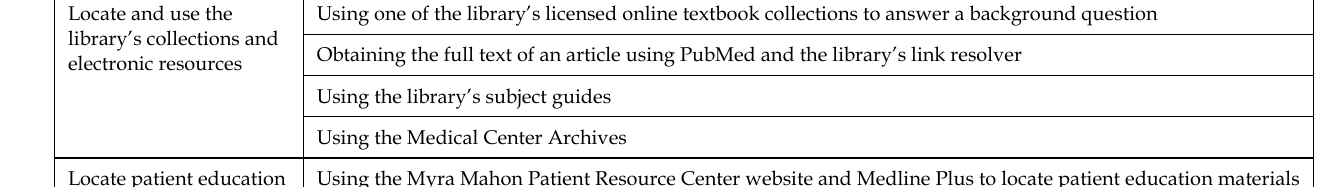
Table 1 Learning objectives and tasks Learning